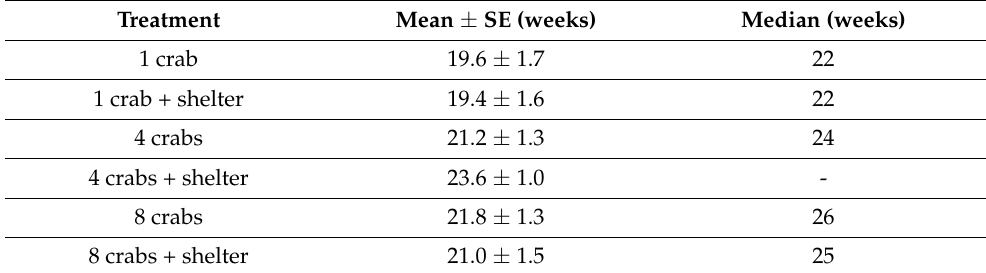
Table 2. Mean ( ± SE) and median survival times for C. maenas maintained for 6 months at densities of 1, 4, and 8 crabs, with or without the addition of shelter ( n = 24 per